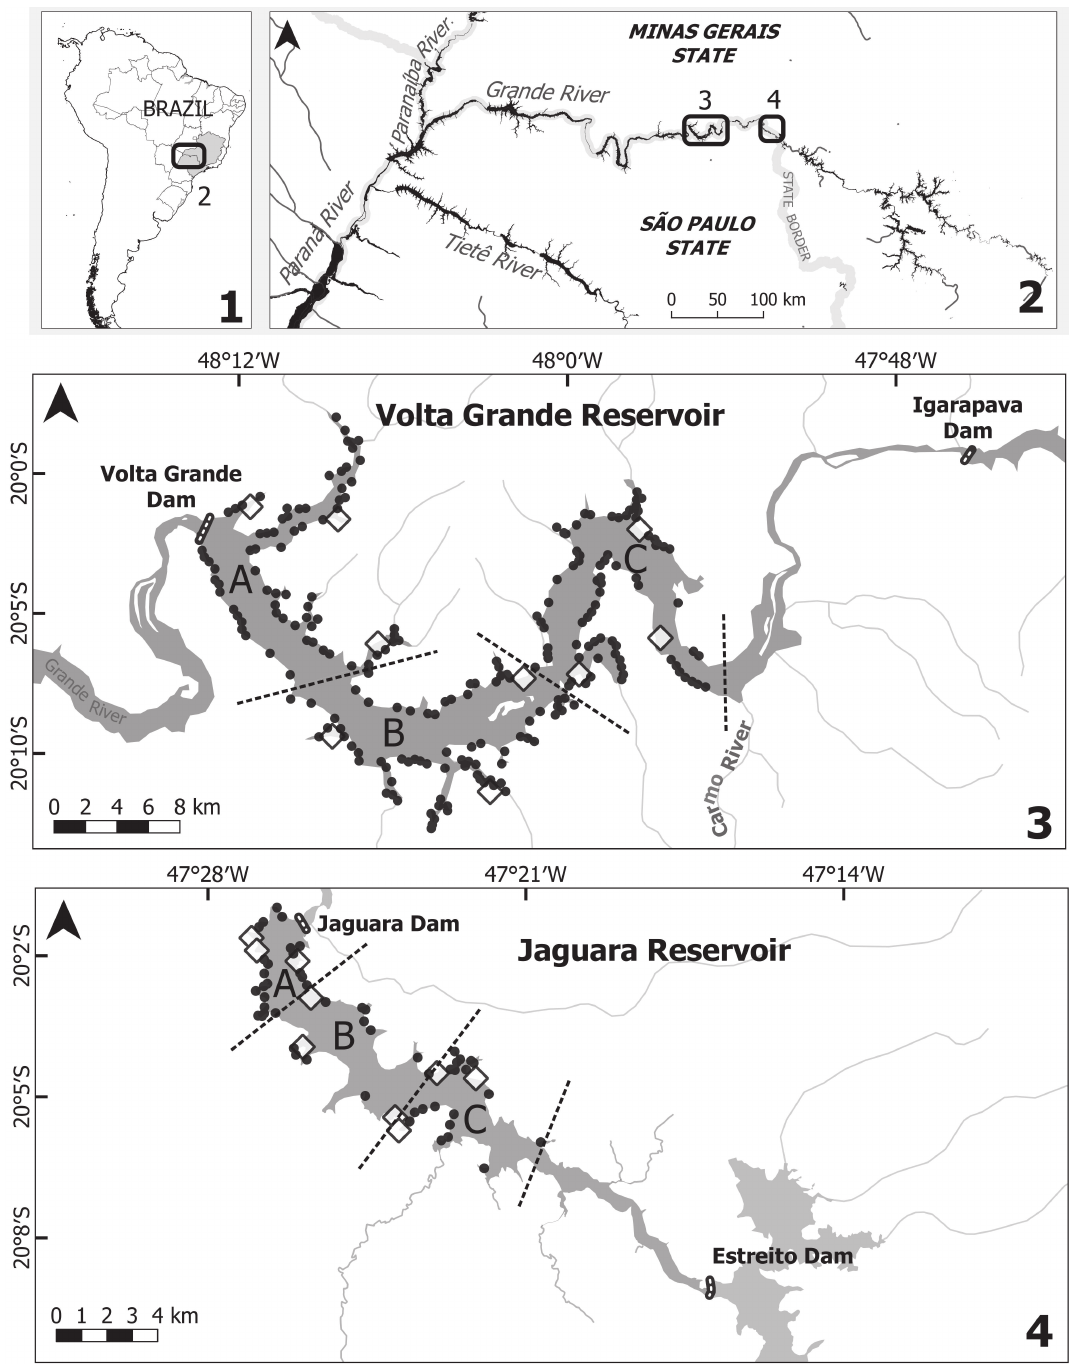
Fig. 1. Maps of the regional location of the study area (1), of Grande River (2) and Volta Grande (3) and Jaguara (4) reser- voirs, indicating the zones of the reservoirs (A, B and C) and fixed (diamond) and variable (black circle) sampling sites. the line option of the “rule tool” of Google Earth (GE), ex- in a counterclockwise direction. We used this same criterion cluding 9 km upstream of the lentic habitat, due to an excess to define the third sampling site in relation to the second, and of macrophytes that prevented the use of gillnets. The line so on for the entire perimeter of the reservoir. We excluded generated with GE was 299.5 km long and had 3,631 wa- sampling sites located in front of countryside houses, in the ypoints. The first sampling site was randomly drawn from urban area and in the security area of the dam. After exclu- all waypoints. We then defined the second sampling site as sions, 465 sampling sites remained, representing about 78% the closest waypoint within 500 m of the first sampling site of the initial